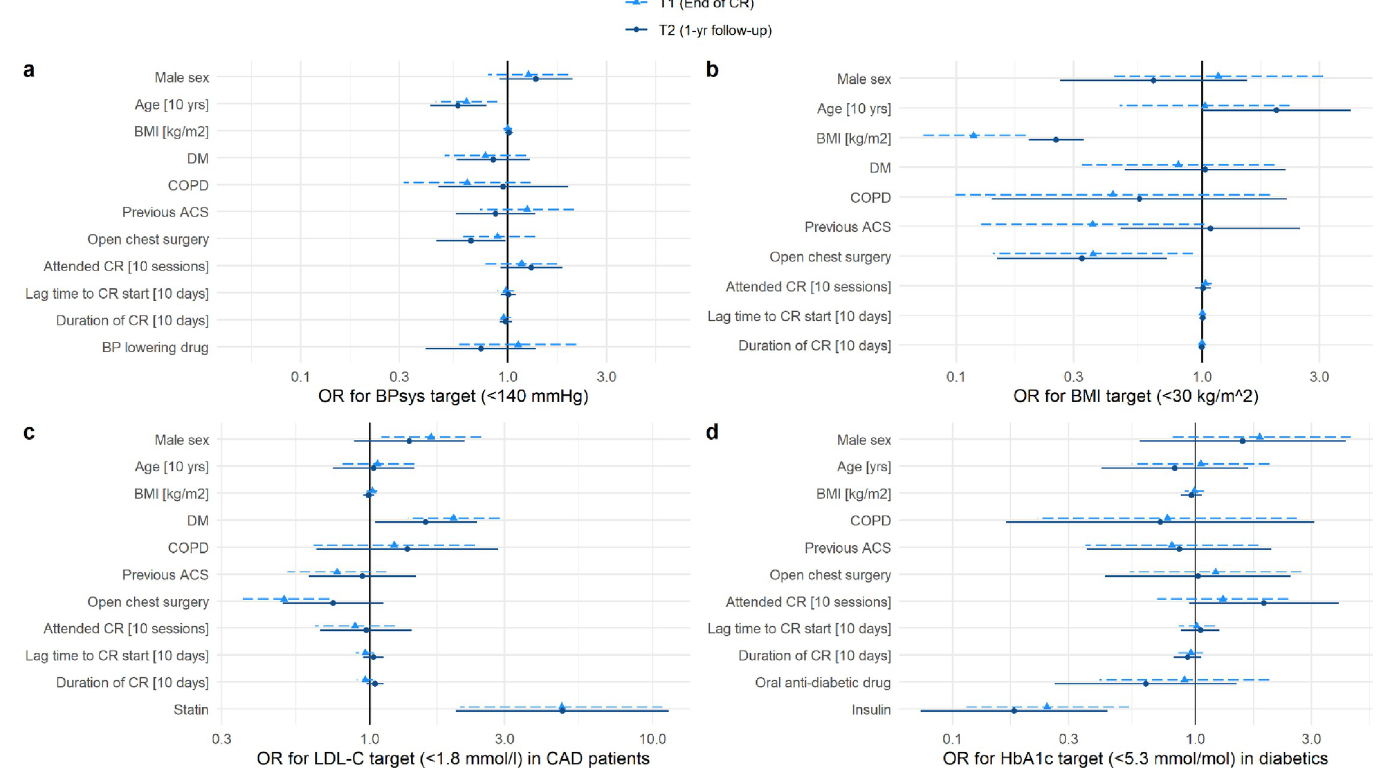
Fig 3. Predictors for reaching target levels of secondary outcome parameters at T1 and T2. Shown are odds ratios and 99% confidence intervals of included parameters from the logistic mixed regression model for reaching target BPsys (a), target BMI (b), target LDL-C in CAD patients (c), and target HbA1c in diabetic patients (d). Centres (random factor) are not shown. Number of patients included in the models for T1 and T2 were 1451 and 1305 for BPsys, 1455 and 1311 for BMI, 1203 and 1058 for LDL-C (excluding VHD patients), and 314 and 280 for HbA1c in diabetic patients. BMI, body mass index; DM, diabetes mellitus; COPD, chronic obstructive pulmonary disease; ACS, acute coronary syndrome; CR, cardiac